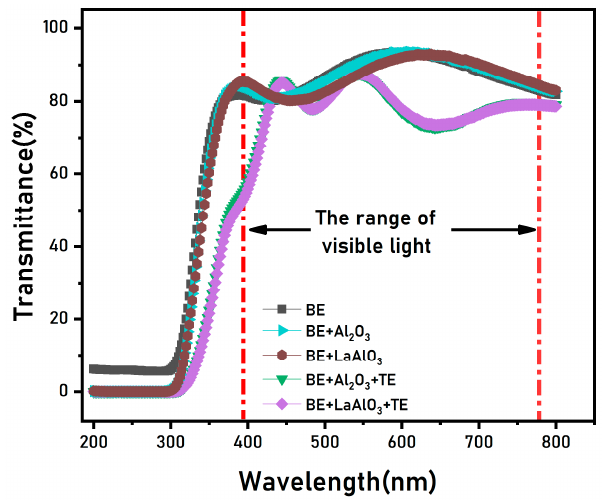
Figure 3. Wavelength—Transmittance diagram of RRAM.